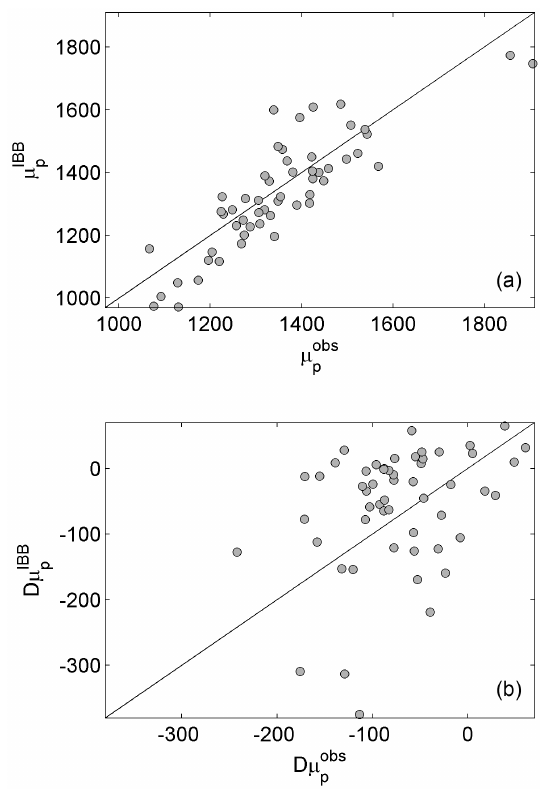
Figure 5. Annual mean precipitation (top panel) during the vali- dation period (1994–2008) and its difference (bottom panel) with the test period (1976–1993) for the observed data (abscissa) and the IBB-simulated data (ordinate) over all the employed stations in South Korea. For more details about the difference at the bottom panel, see Eqs. (12) and (13).